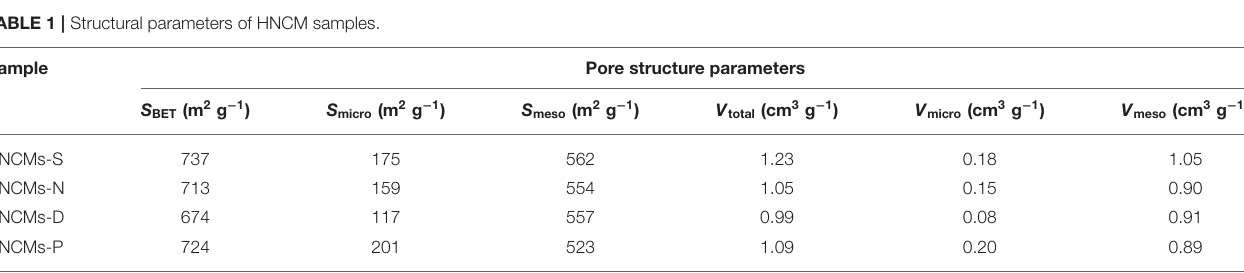
TABLE 1 | Structural parameters of HNCM